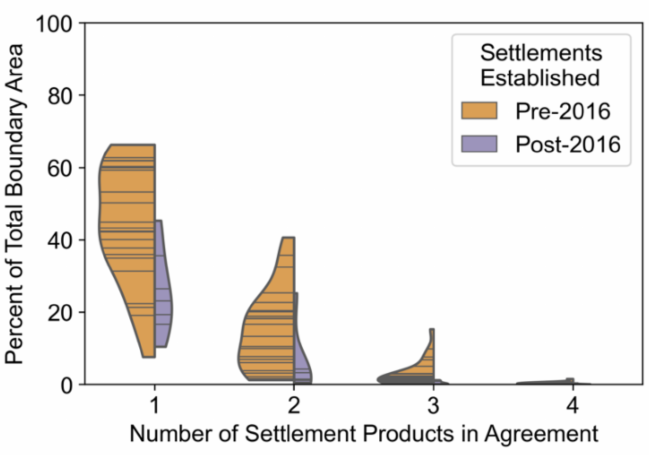
Figure 11. Violin plots of the area of settlement product agreement reported as a percentage of the UNHCR settlement boundary area for settlements established pre- and post-2016. Black horizontal lines in violin plots represent individual settlement